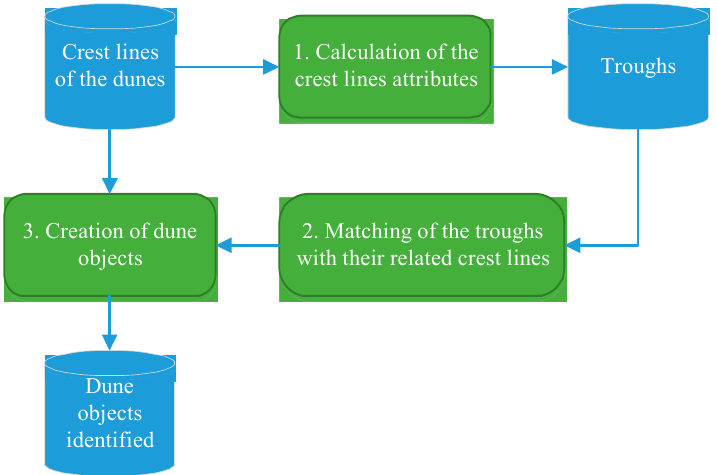
Figure 6. Phase II of the dune segmentation approach.